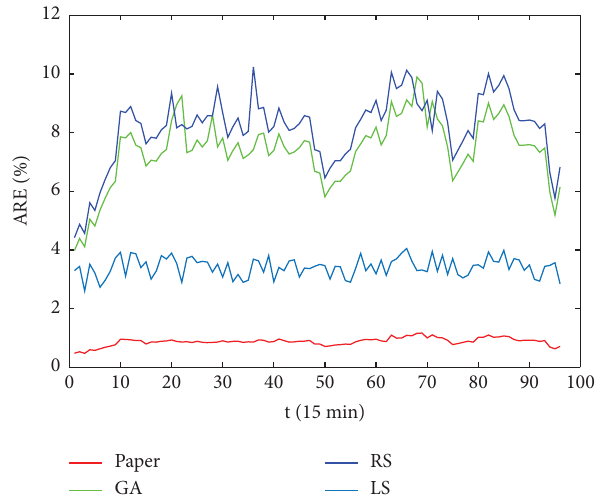
Figure 7: ARE of voltage under diferent